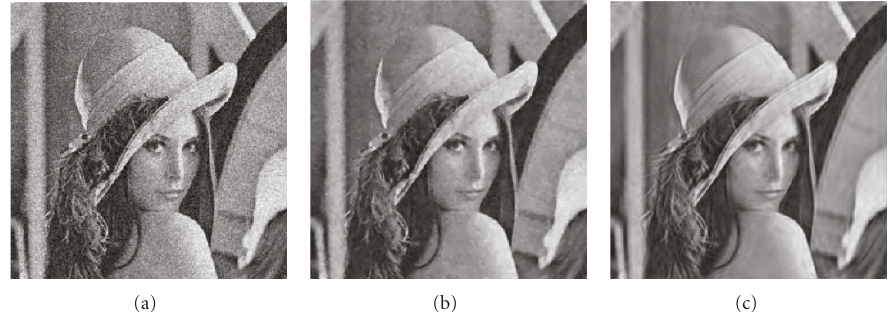
Figure 1: (a) The noisy “Lena” image with standard deviation 35; (b) the denoised “Lena” image by the TV algorithm; (c) the denoised “Lena” image by the curvelet hard shrinkage